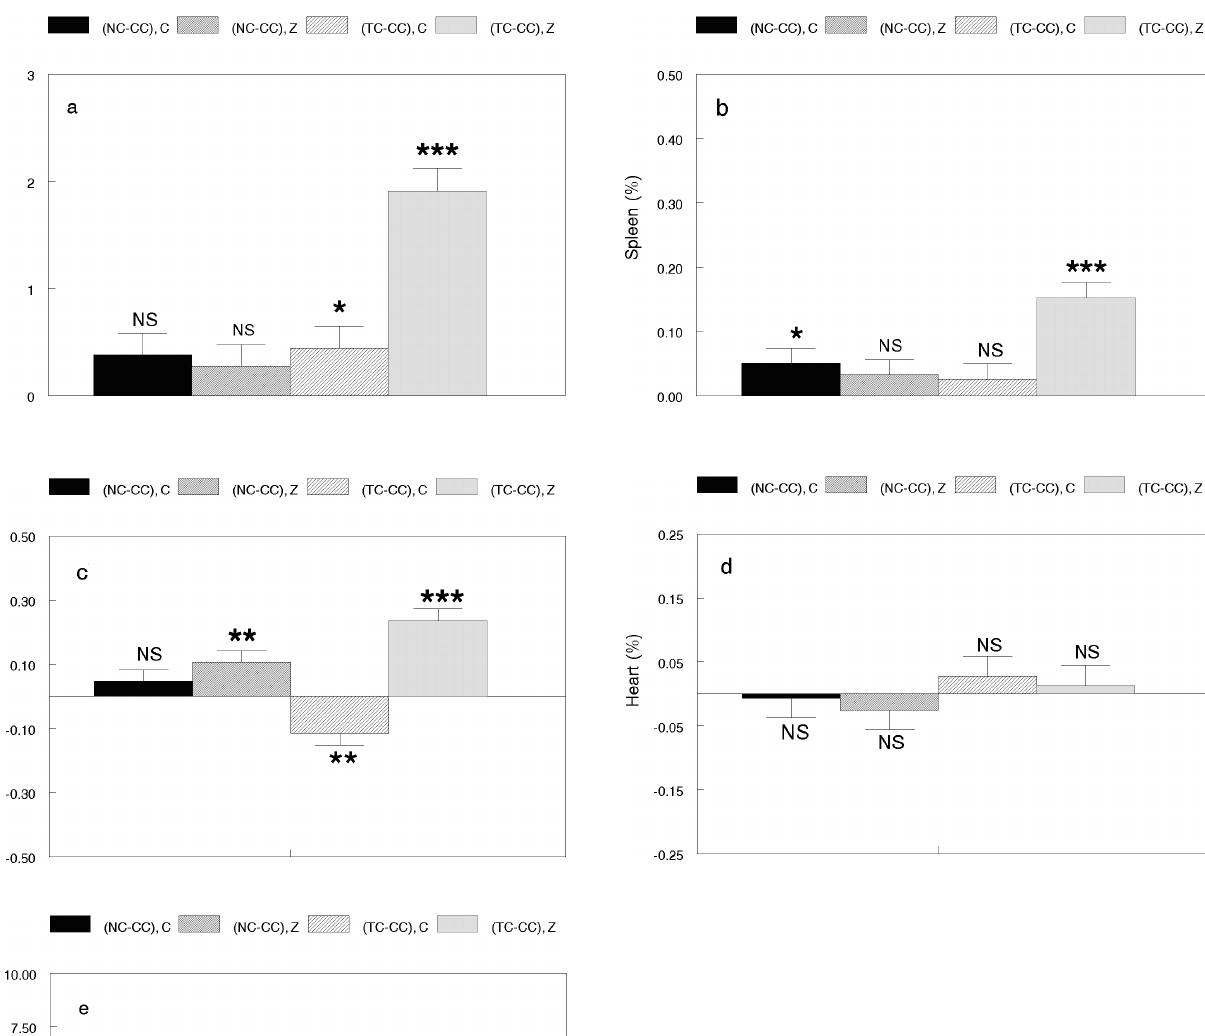
Figure 2 - Correlated responses for organ weights as a percentage of 8- week body weight in the NC and TC lines with (Z) and without (C) zinc supplementation expressed as deviations from the means of CC, the ran- domly selected control line: a ) liver, b ) spleen, c ) kidney, d ) heart, e ) testis. NC and TC are nontransgenic and transgene-carrier lines, respectively, originating from the same background as CC, and subsequently selected for 8-week body weight. NS = Not significant, *P < 0.05. **P < 0.01, ***P <